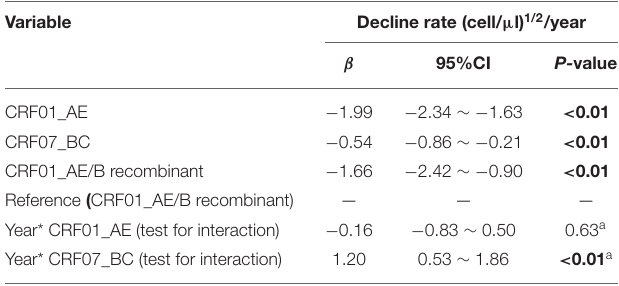
TABLE 2 | The analysis of annually decline rate of CD4 + T-cell count using generalized additive mixed model (GAMM).